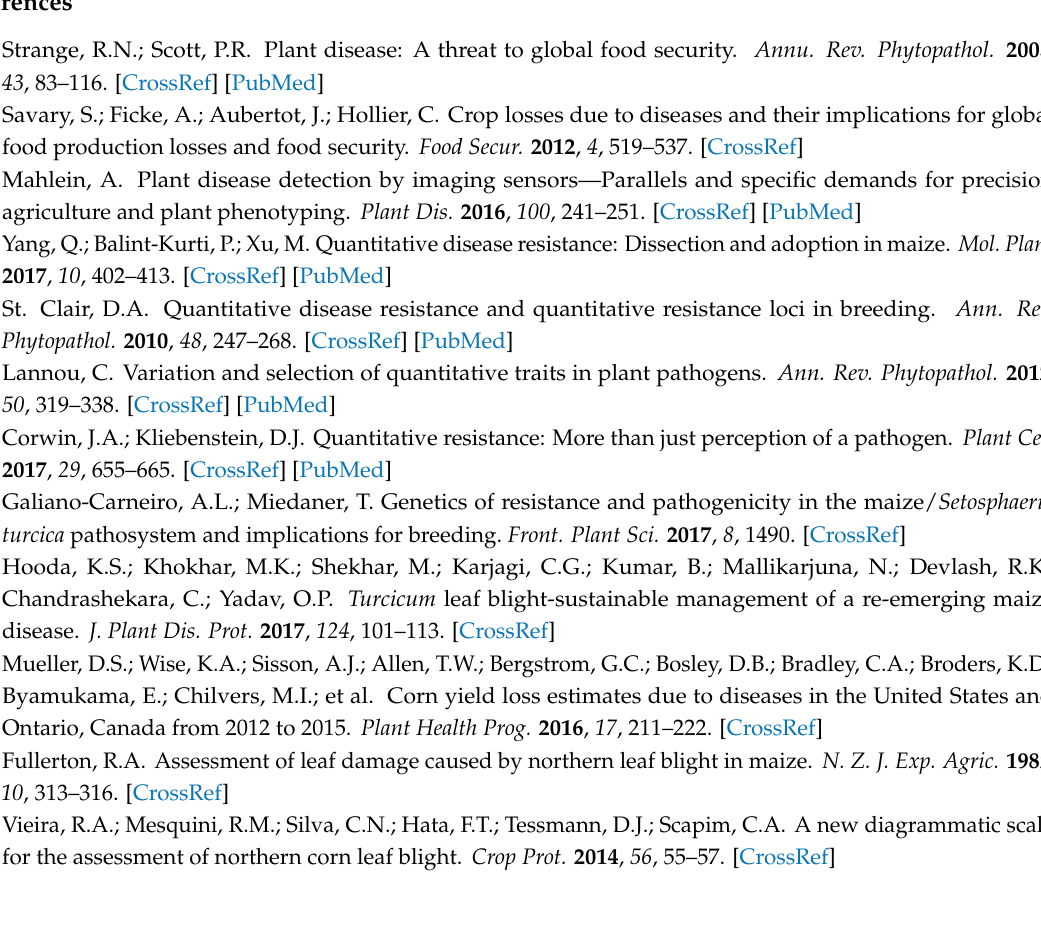
Figure A2. Graphical representation of the method used to determine the crop dimensions of lesions from full-size images. The annotation line denotes the location of the lesion in the image (solid red line) and corresponding bounding box (dashed grey line). The dimension of the final crop location (solid grey arrows) from the center point of the annotation line is determined using the equation from Section 2.1 in the Materials and Methods. The solid blue line denotes final crop